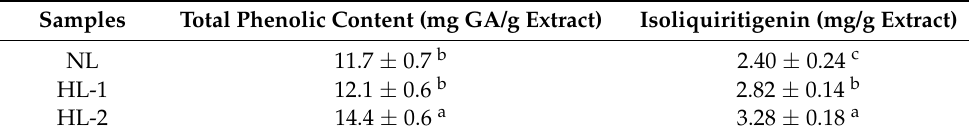
Table 3. Total phenolic and isoliquiritigenin content of licorice